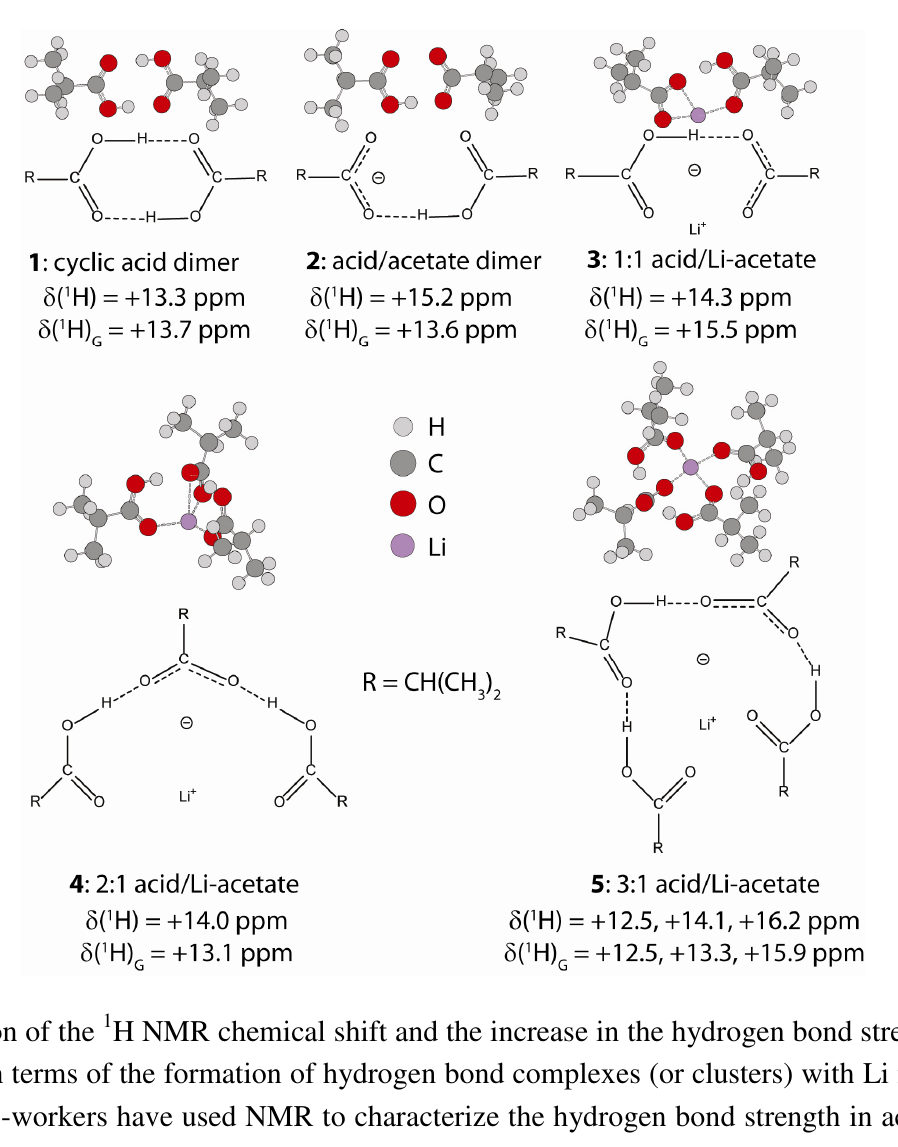
Figure 3. Structures of the model isobutyric/Li acetate hydrogen bond complexes, and the 1 H NMR chemical shift predicted using either Equation 2 ( δ ) or with Gaussian ab initio methods ( δ G